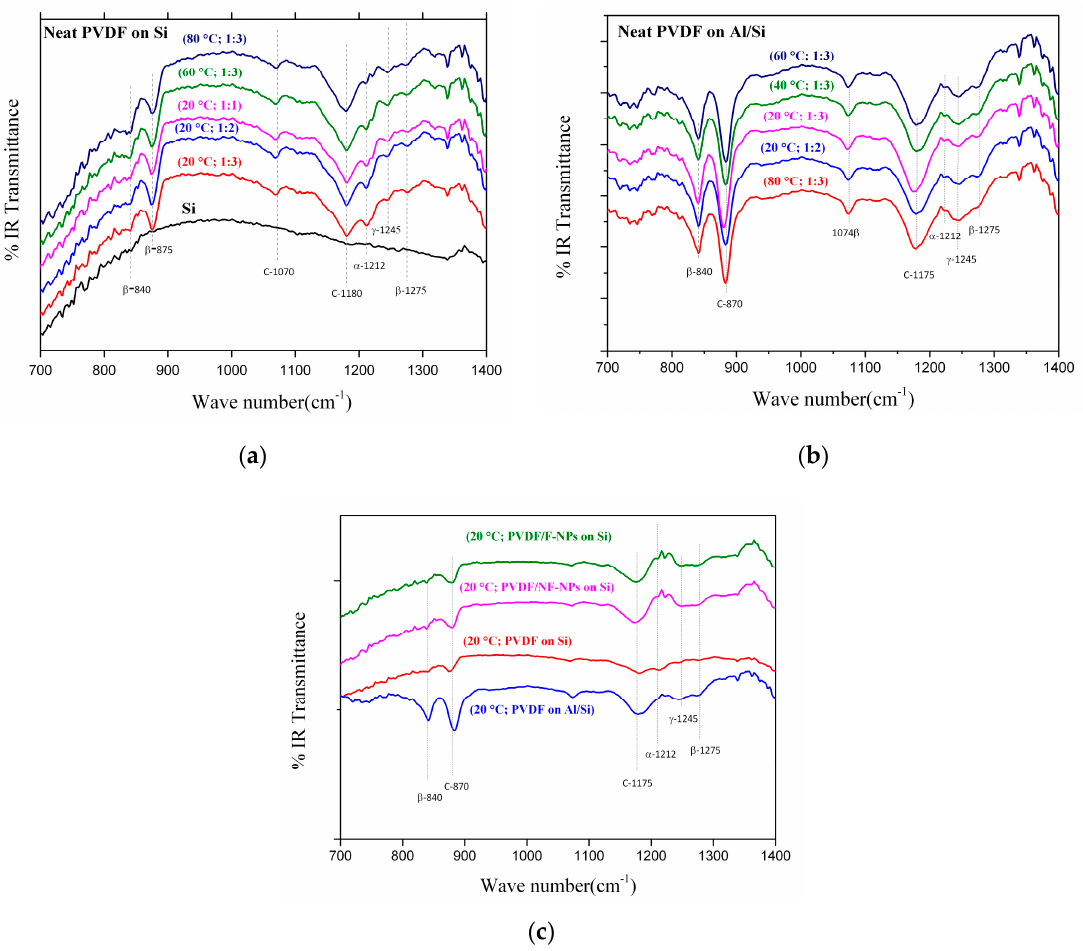
Figure 7. ( a ) IR transmittance of neat PVDF thin films on Si substrate with different elaboration parameters detailed in parenthesis (temperature; DMF/acetone ratio); ( b ) IR transmittance of neat PVDF thin films on Al/Si substrate with different elaboration parameters detailed in parenthesis (temperature; DMF/acetone ratio); ( c ) comparison between neat PVDF thin films on Si and Al/Si and composite thin films obtained by equal conditions of elaboration with functionalized (F-NPs) nanoparticles and non-functionalized ones (NF-NPs).